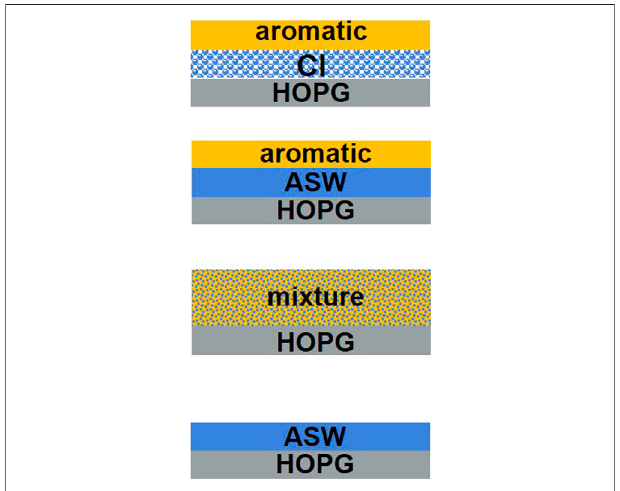
FIGURE 2 | Schematic showing the different ice con fi gurations investigated. The ice con fi gurations were (from top to bottom) layered ices consisting of the aromatic molecule adsorbed on top of CI and on top ofASW and binary mixtures of the aromatic molecule with ASW. The bottom schematic shows the pure water system which was also studied to provide a reference for the TPD